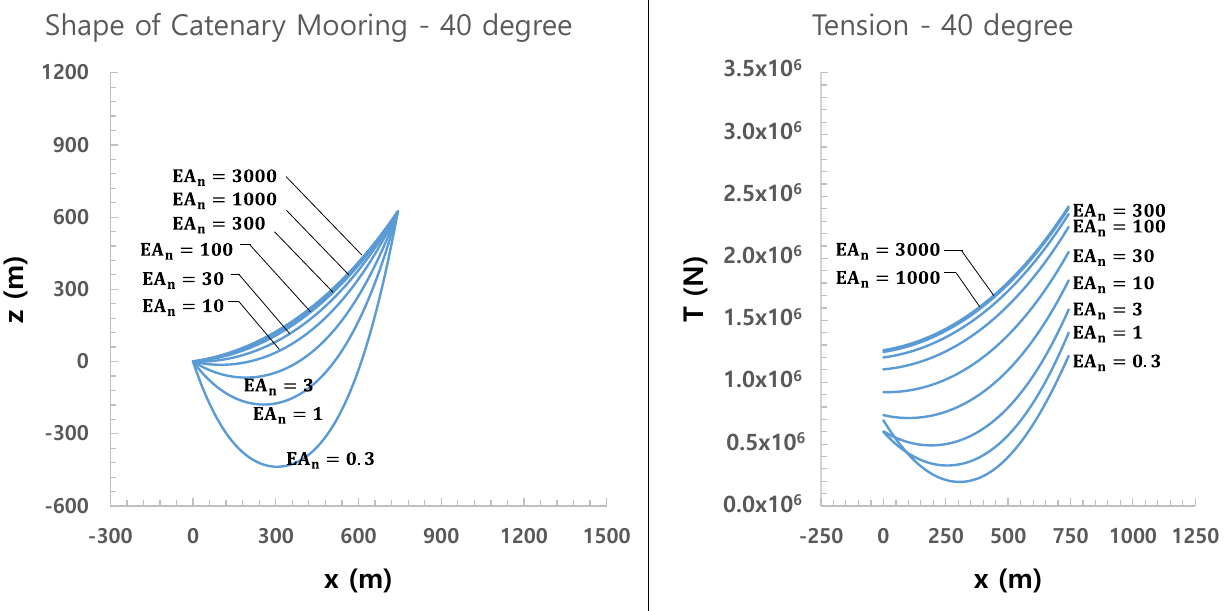
Figure 7. Result for static analysis of mooring line when q is 40°.